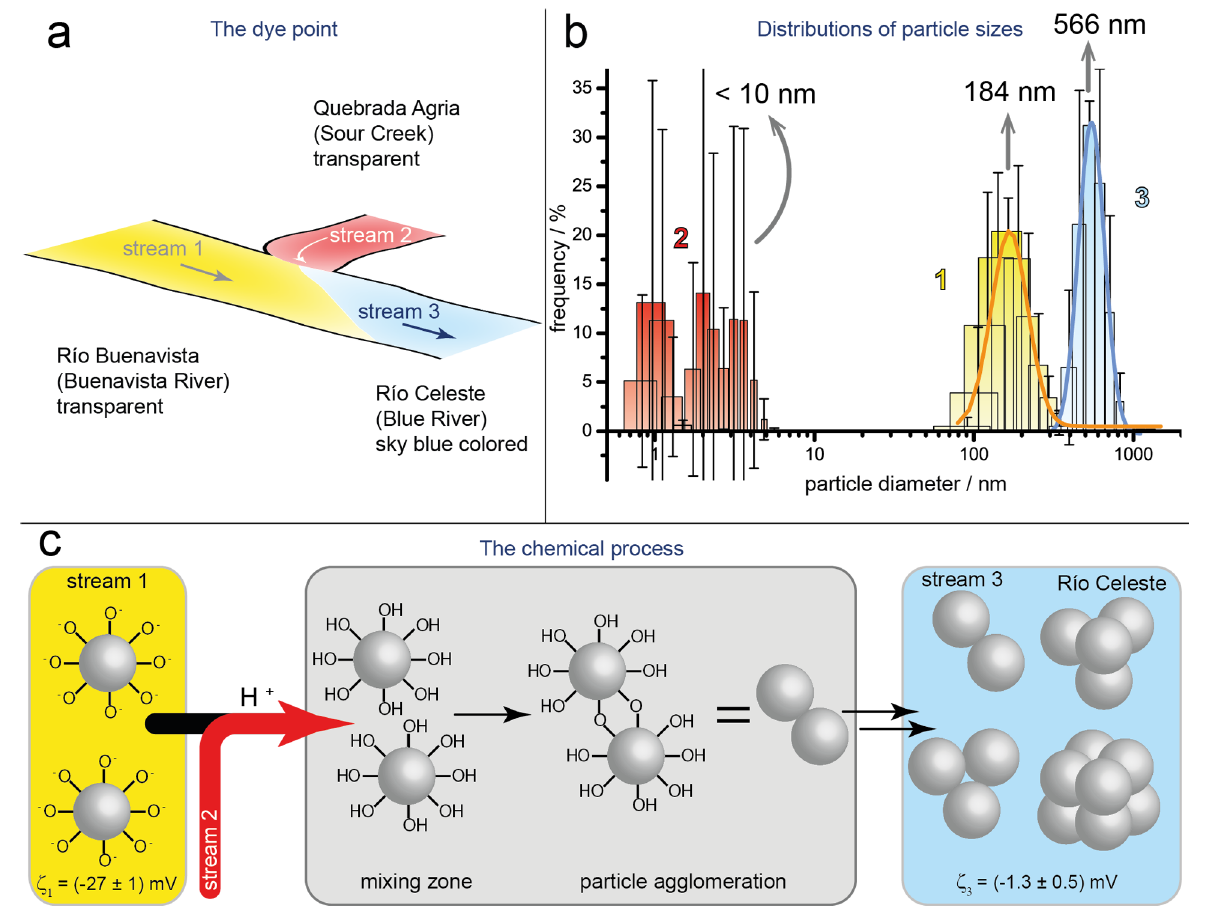
Figure 3. Dynamic light scattering experiments and the mechanism of enlargement of colloidal particles. ( a ) Sketch of the confluence of Rı´o Buenavista (stream 1, yellow) and Quebrada Agria (stream 2, red). Mixing of the two streams produces the appearance of the sky-blue color (stream 3, Rı´o Celeste in blue). ( b ) Hydrodynamic diameter distribution of particles (measured by intensity) in the suspended material in the three streams. Colors and numbers represent the positions in Fig. 3a. ( c ) The chemical mechanism of enlarged particles after mixing of the water streams at the dye point (‘‘Ten˜idero’’).